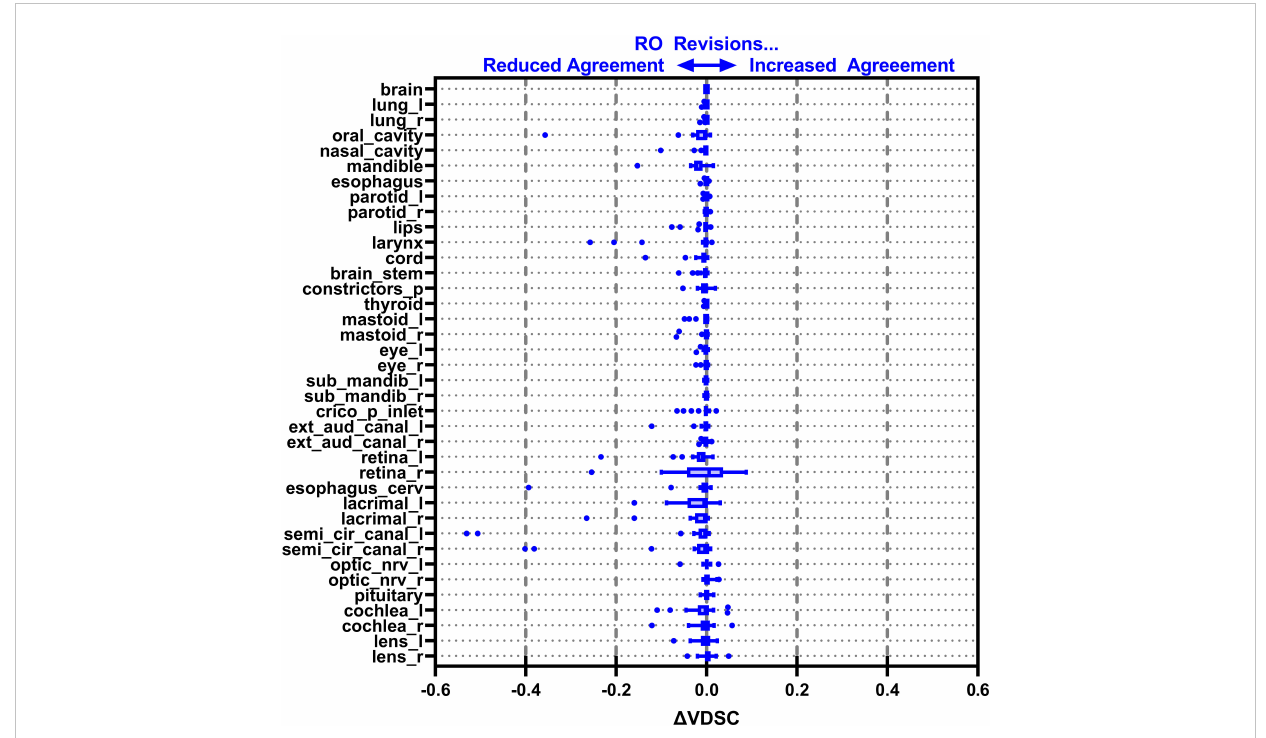
FIGURE 7 Box-and-whisker plot showing the change in agreement with the gold standard (GS) before (DL) and after (DL+RO) the radiation oncologist ’ s (RO ’ s) revisions to the deep learning (DL) contours measured by volumetric Dice similarity coef fi cient (VDSC). A positive value indicates that the revisions improved agreement with the GS, and a negative value indicates reduced agreement. OARs listed in order of decreasing volume.